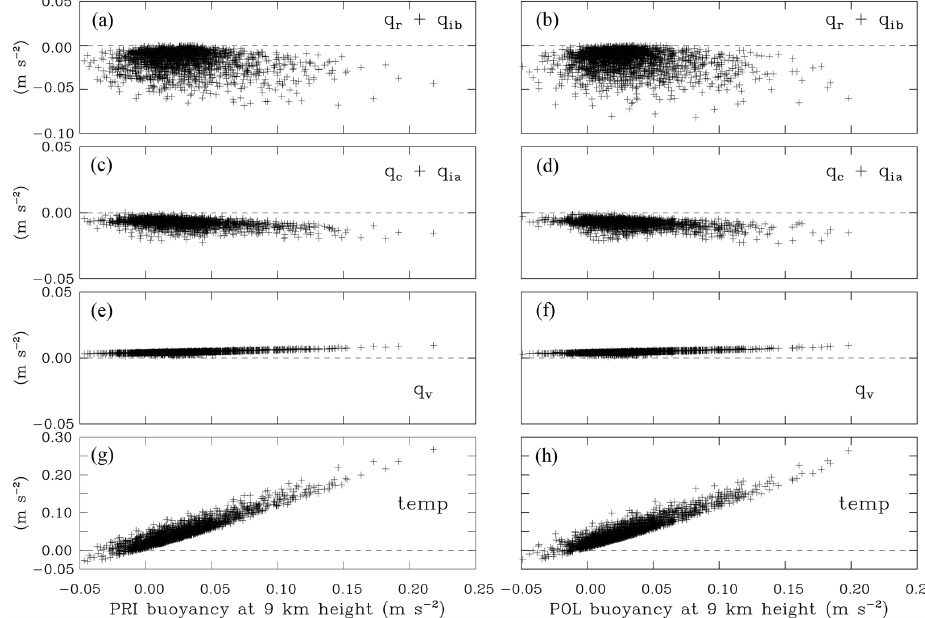
Figure 9. Like Fig. 8, but at 9km. Panels (a, b) include rain combined with ice B mixing ratios; panels (c, d) include cloud water combined with ice A mixing ratio.